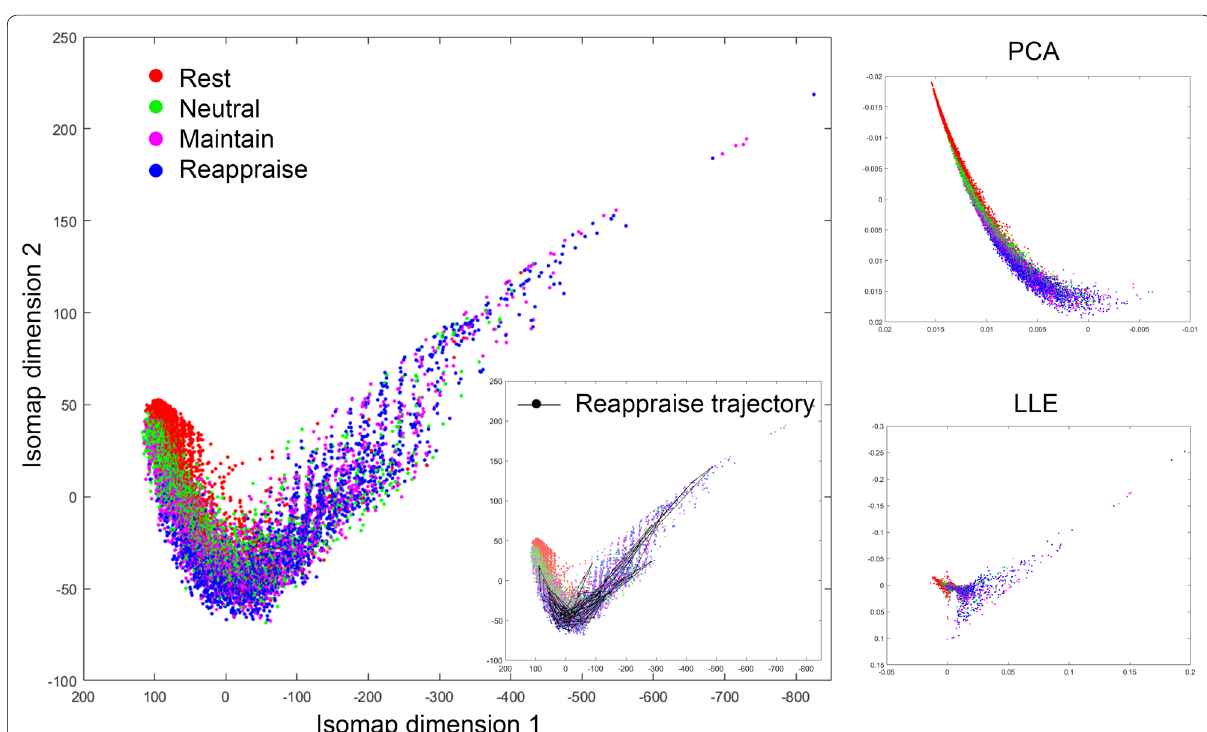
Fig. 2 An example Thought Chart during Reappraise learned from the temporal EEG connectomes of 20 healthy subjects, both at rest and during ERT, using NDR methods of isomap (left) and LLE (lower right), as well as standard PCA (upper right). Visually, NDR methods yielded an ordered transition from resting, Neutral, Maintain to Reappraise along the manifold’s principal dimension (isomap dimension 1)